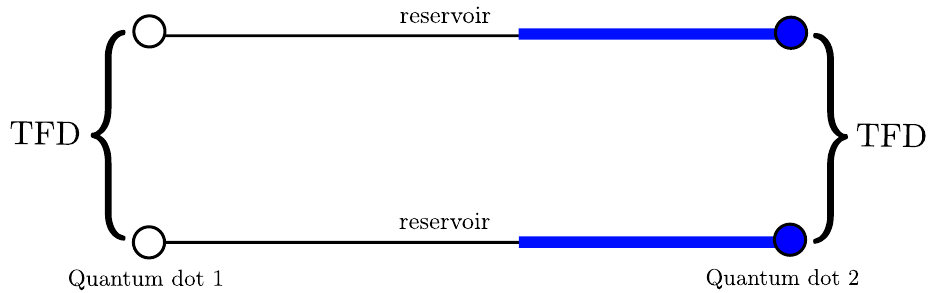
Figure 9. We collect the radiation in the bold blue segments of radiation that include the boundary duals (quantum dots) of the second eternal black